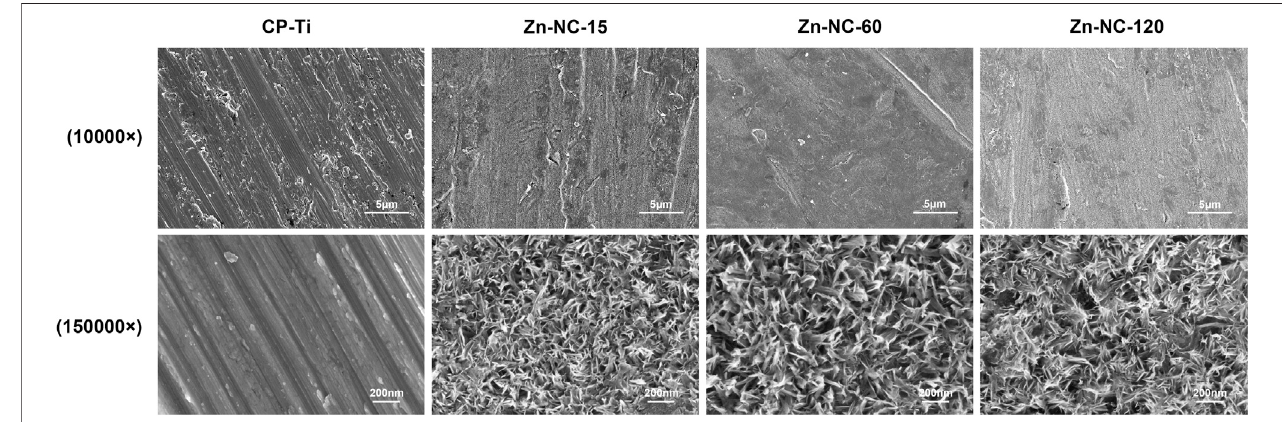
FIGURE 1 | Scanning electron microscopy images of the surface morphology of the different synthesized surfaces. Upper panel: × 10,000 magni fi cation; lower panel: × 1,50,000 magni fi cation.